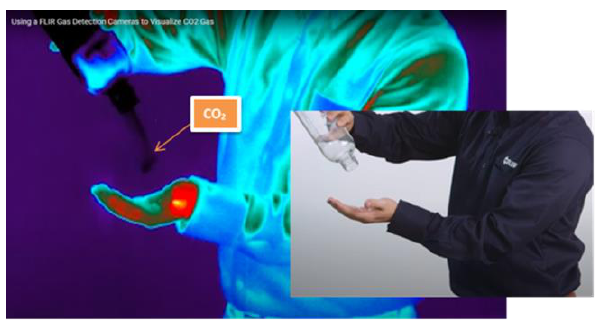
Fig. 10. Image from a thermal imaging camera and a standard camera showing the outflow of carbon dioxide CO 2 from a bottle